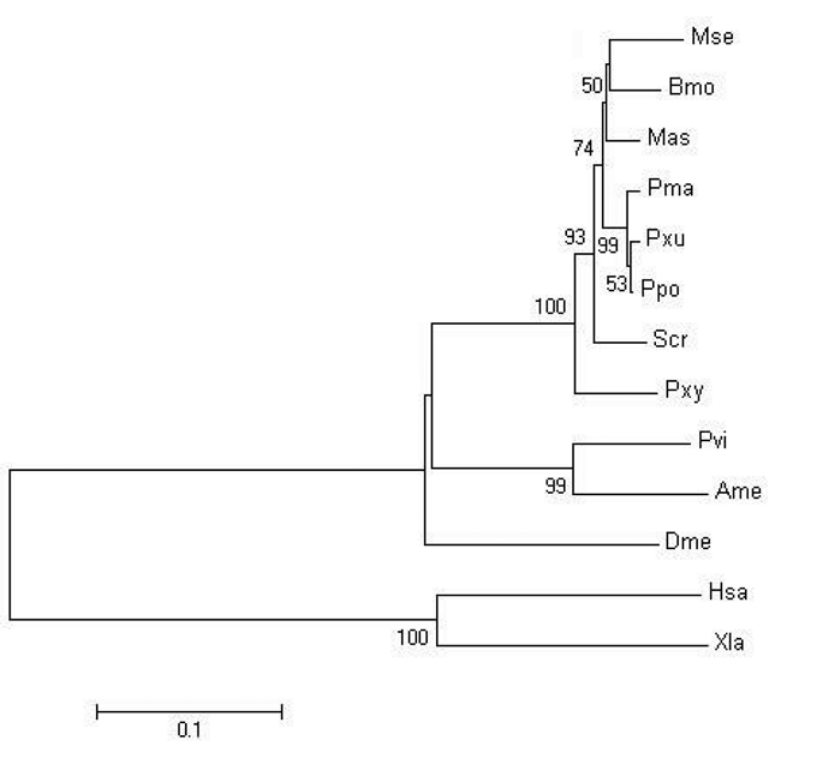
Fig.6. Phylogenetic tree which shows the evolutionary relationship of PvtH with other members of the tH family constructed on the basis of alignment of the animo acid sequences of tH homologues. Numbers at branch nodes indicate percent bootstrap confidence values derived from 2000 replications. see Figure 5 for the explanation of species